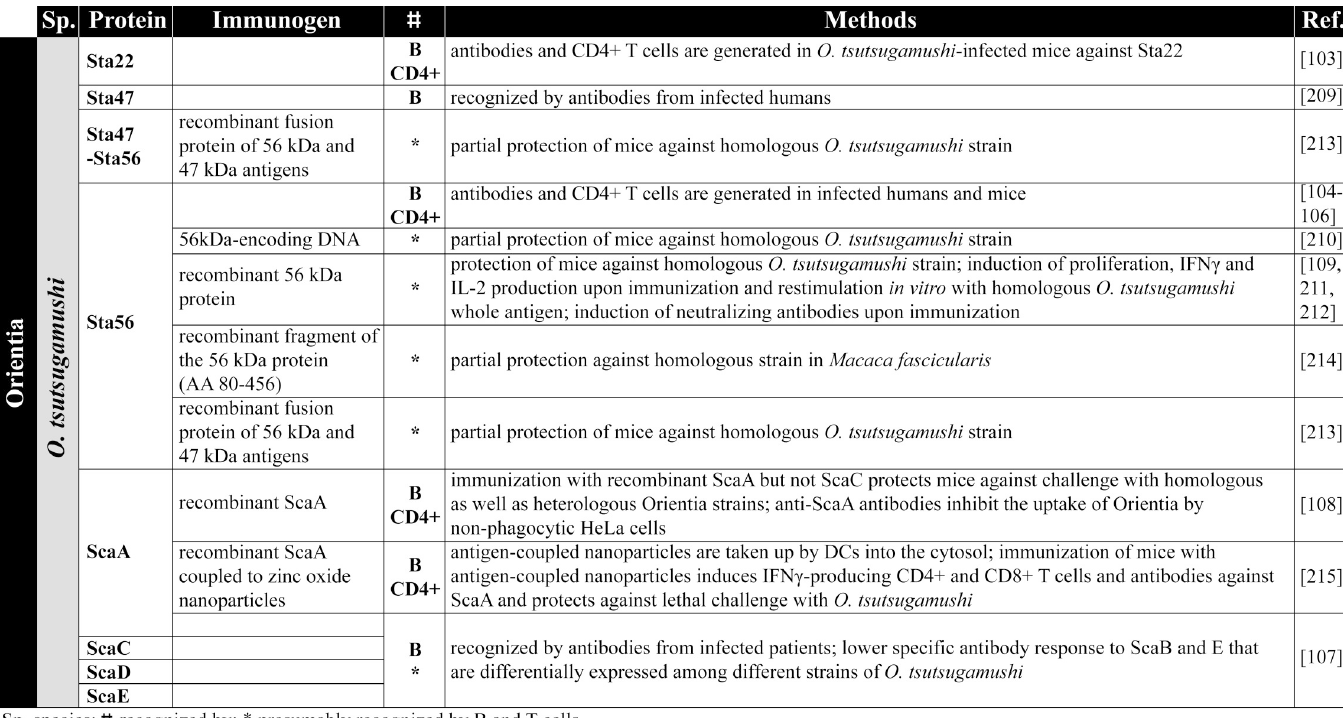
Fig 5. Orientia antigens. The figure summarizes the antigens identified from Orientia [103–109,209–215].DCs, dendritic cells; IFN γ , interferon gamma; IL-2, interleukin 2.